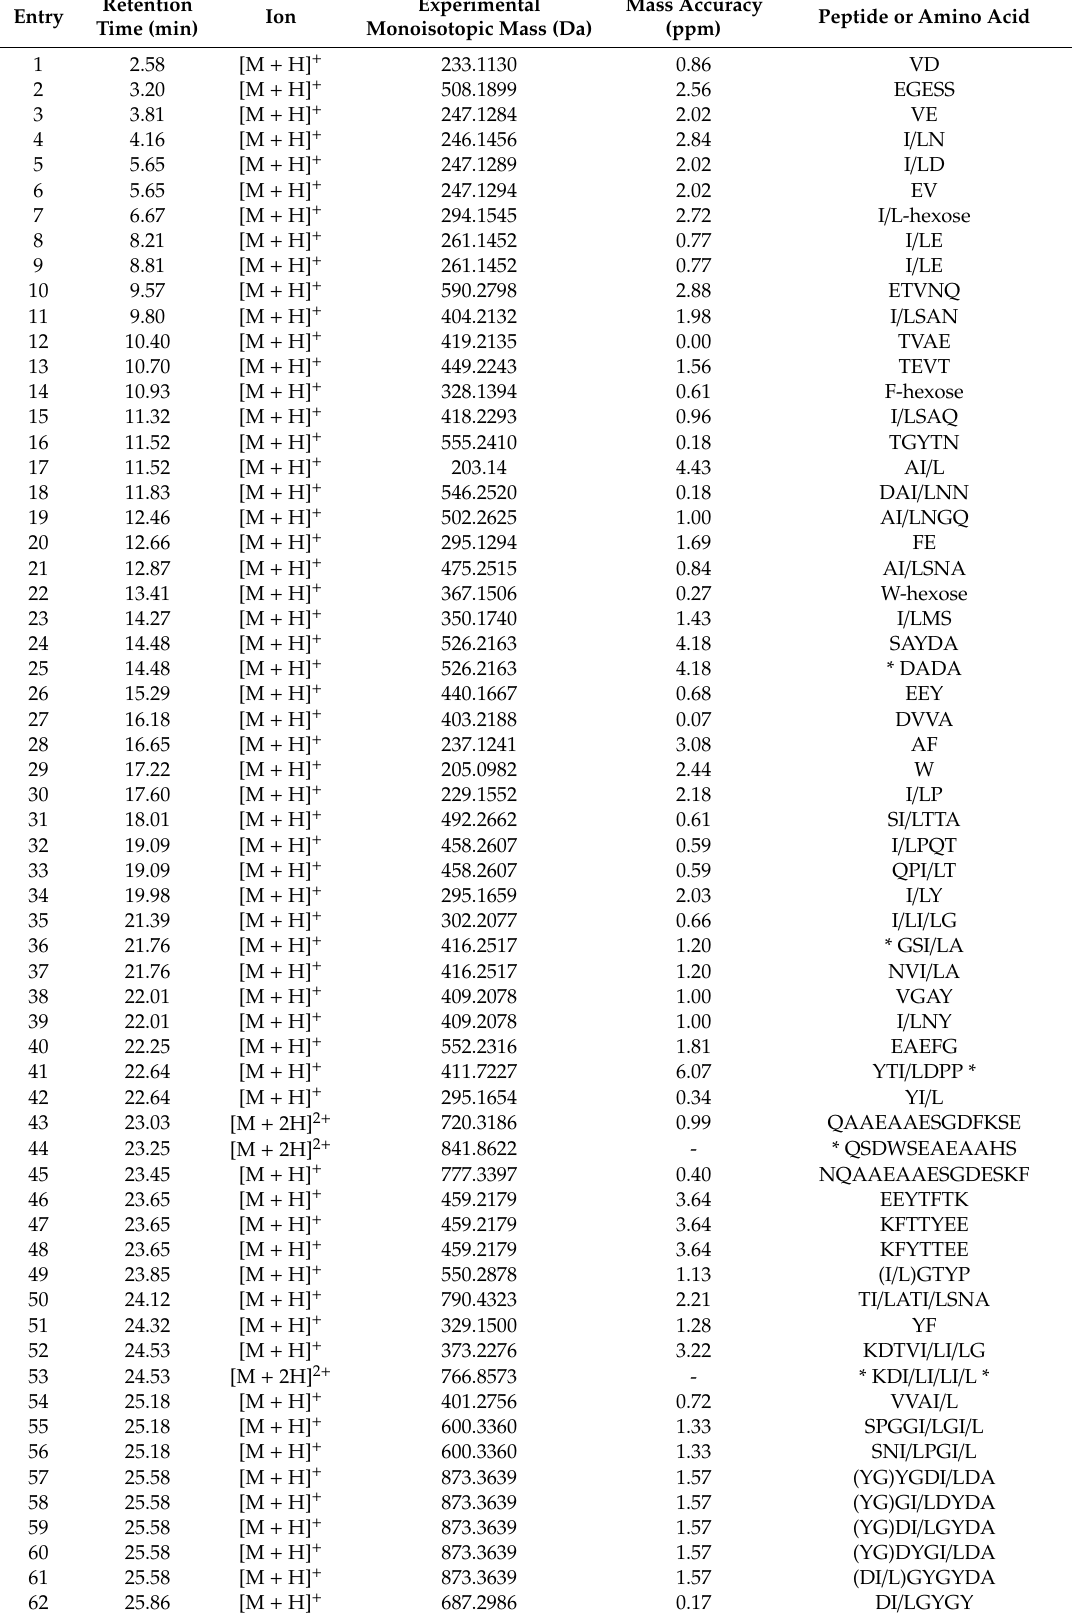
Table 2. Peptide sequences identified by UHPLC-HRMS in the H-PROT-1 (t1h)